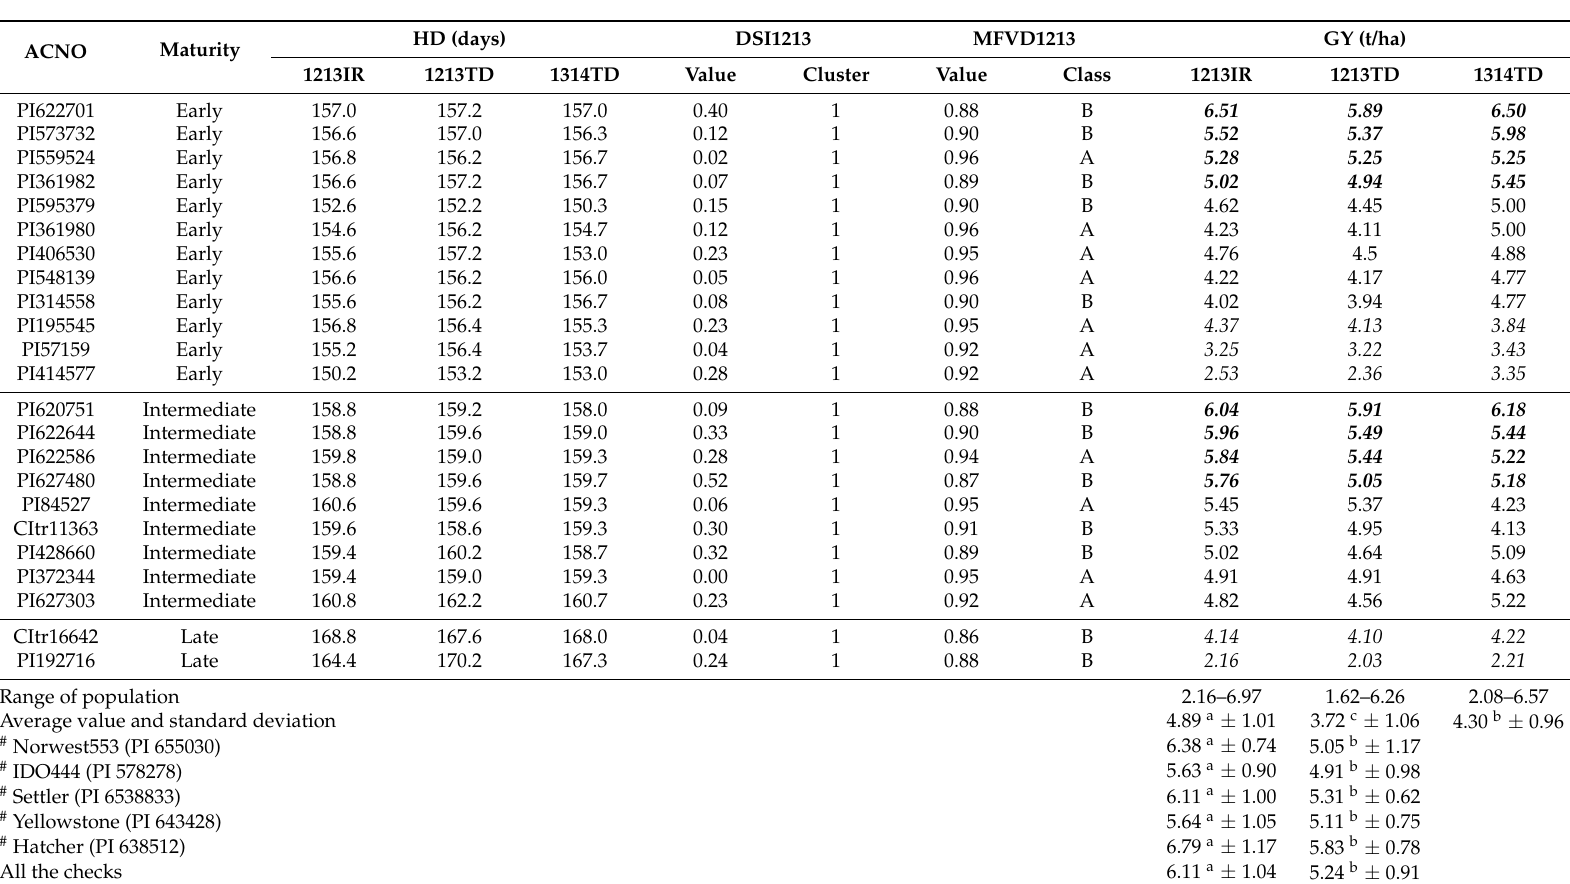
Table 6. Performance of Grain yield (GY) for high drought resistant winter wheat accessions by drought susceptibility index (DSI) and membership function value of drought tolerance (MFVD) and five checks #